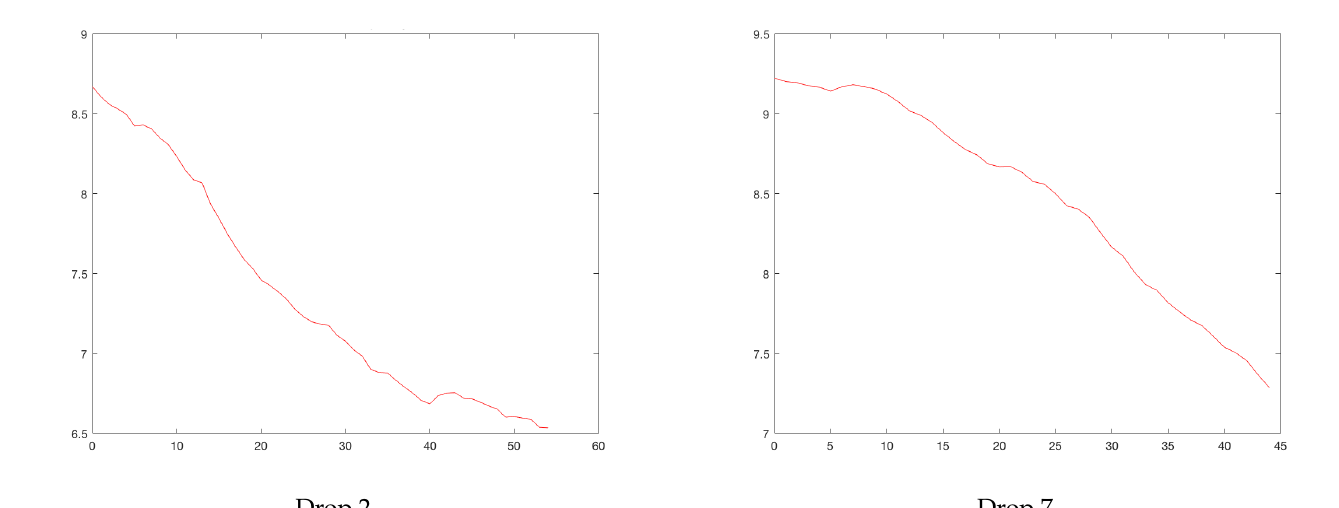
Figure A3. Bogota’s drops. Horizontal axis, days; vertical axis: logarithm of daily cases.